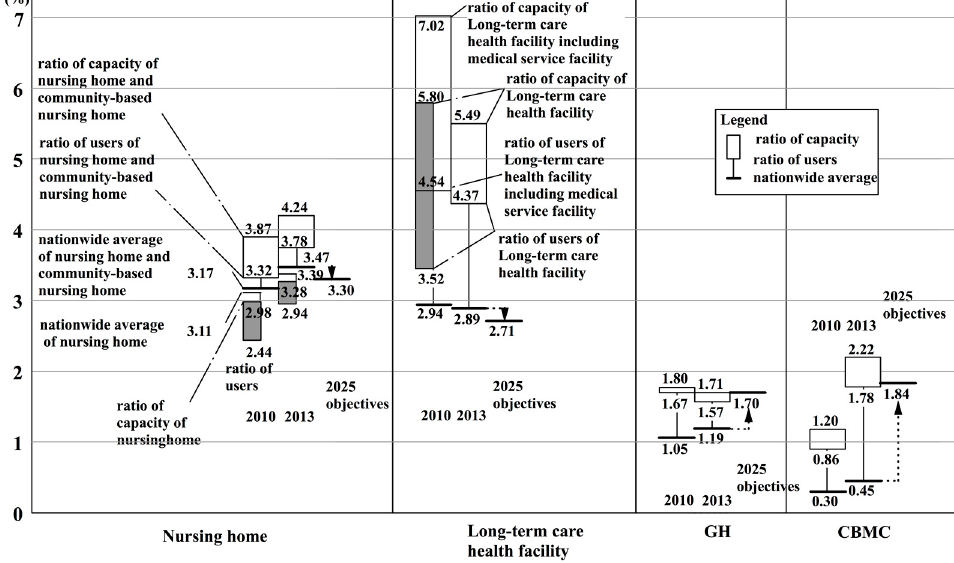
Figure 9. User ratio and establishment objectives on nursing home, long ‐ term care health facility, group living, and community based multi ‐ care facility in 2010, 2013 and 2025.